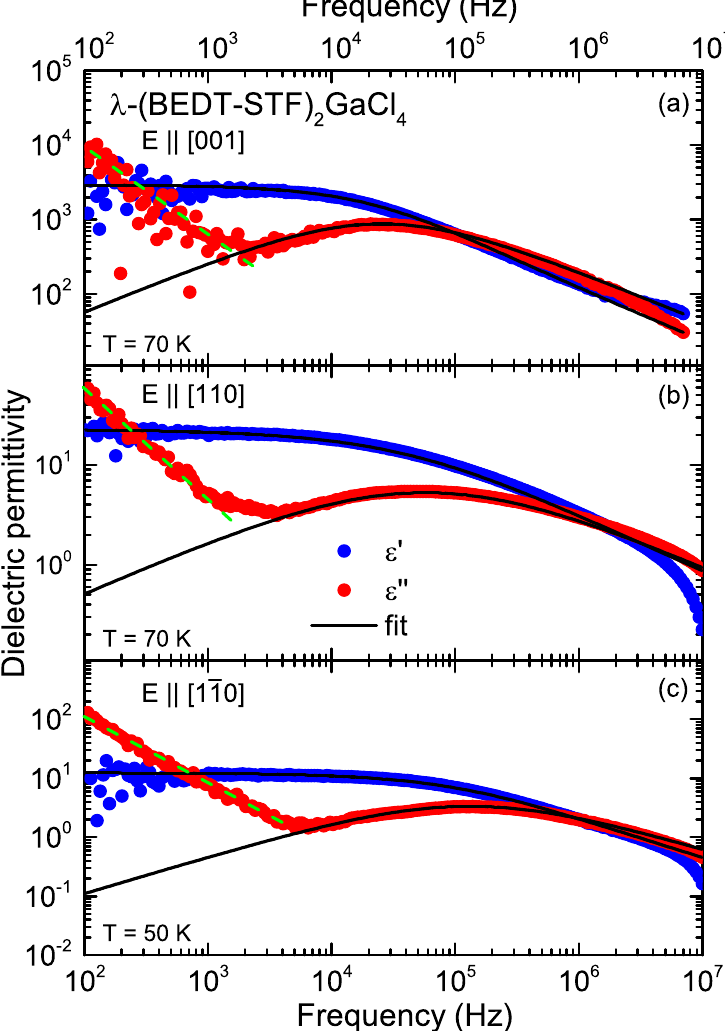
Figure 4. Double logarithmic presentation of the frequency-dependent real and imaginary parts of the dielectric permittivity of λ -(BEDT-STF) 2 GaCl 4 , (cid:101) (cid:48) (blue symbols) and (cid:101) (cid:48)(cid:48) (red symbols). The data are recorded along ( a ) the [ 001 ] - and ( b ) [ 110 ] -directions at T = 70 K and ( c ) for E (cid:107) [ 1¯10 ] at T = 50 K. The solid black lines represent fits by the generalized Debye model; the dashed green lines indicate the dc contribution to the imaginary part of the